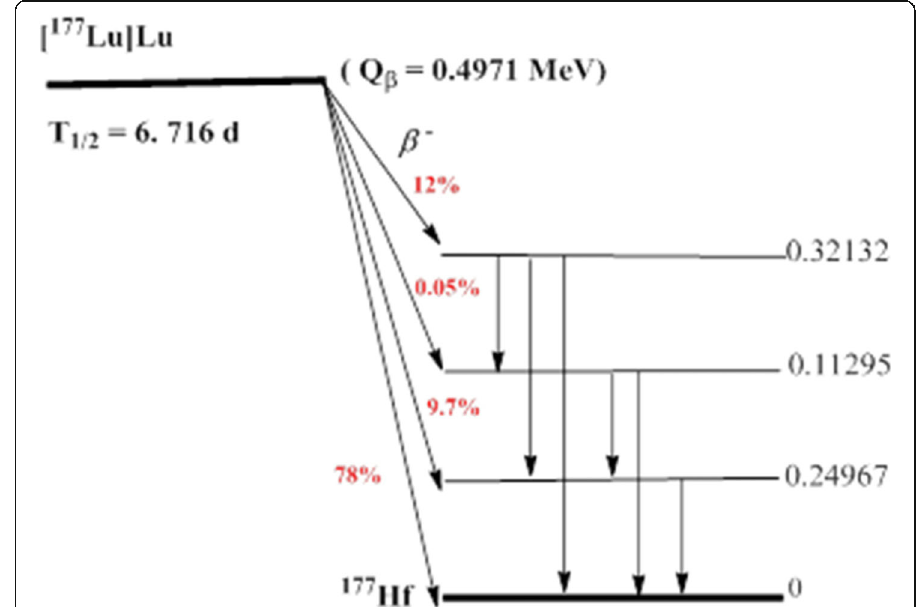
Fig. 2 Decay chain scheme of